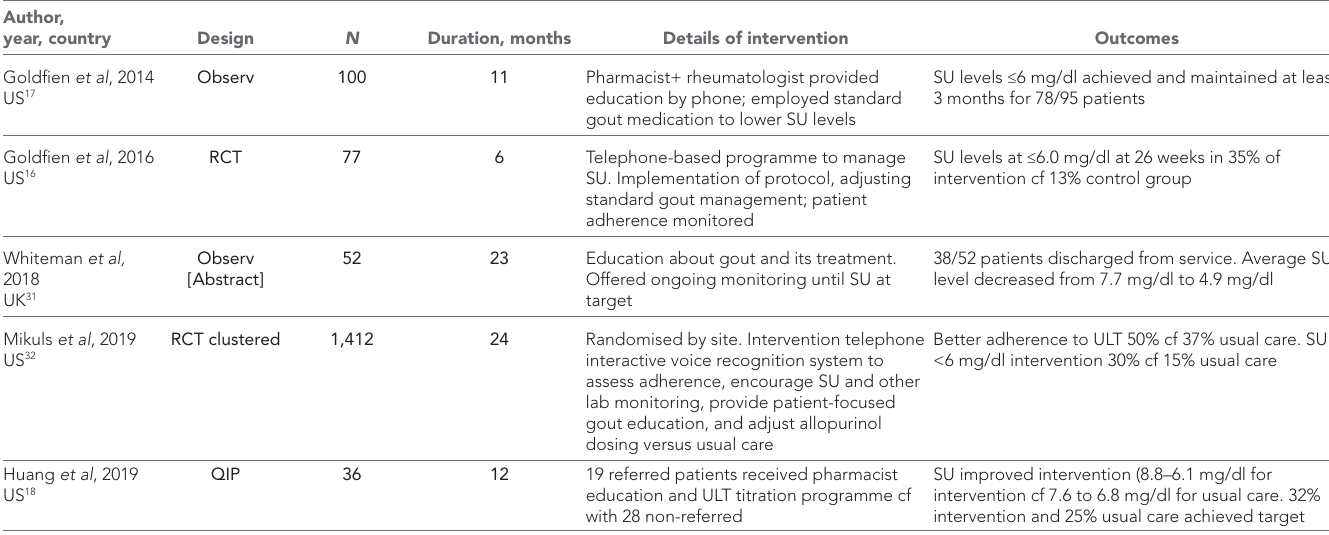
Table 2 Characteristics of included pharmacist- led studies